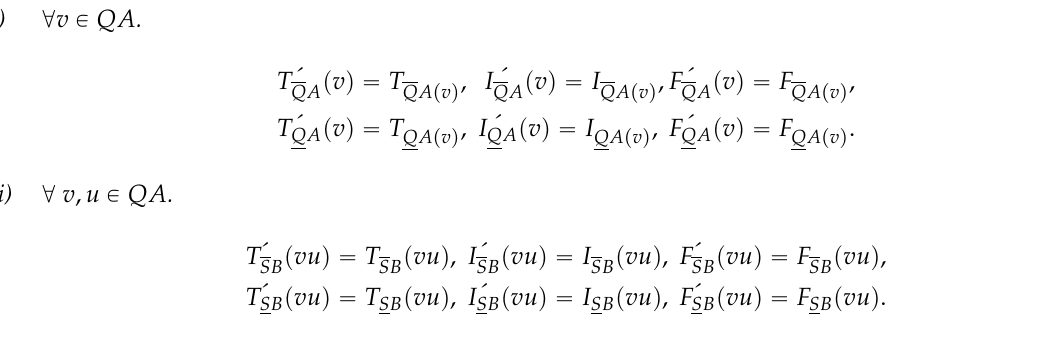
Figure 10: Neutrosophic soft rough graph ´ G = ( ´ G,